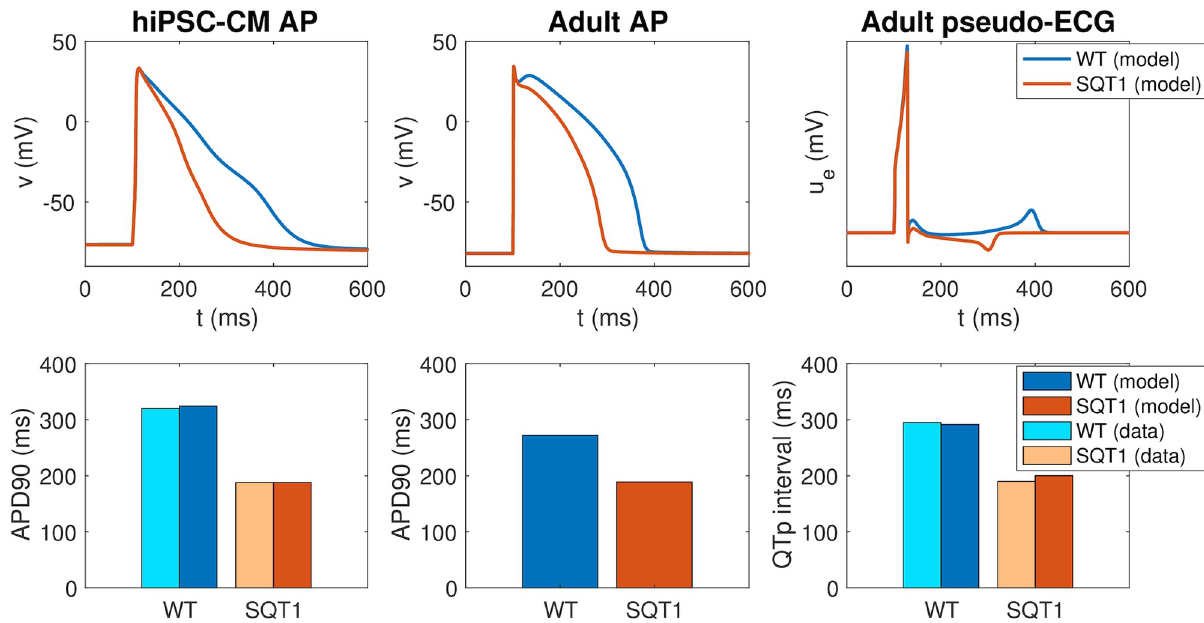
Fig 6. Properties of the base models for hiPSC-CMs and adult ventricular CMs in the WT and SQT1 cases. Upper panel: Comparison of the action potentials computed for the WT and SQT1 versions of the hiPSC-CM (left) and adult (center) models, in addition to the pseudo-ECG for the adult model (right). The only difference between the formulations of the WT and SQT1 models is a shift in the inactivation gate of I Kr as illustrated in the right panel of Fig 5. Lower panel: APD90 values and QTp intervals computed using the WT and SQT1 versions of the models. The computed APD90 values for hiPSC-CMs are compared to data from [9], and the computed QTp intervals for adults are compared to data from [15]. Data used in this figure can be found in S1